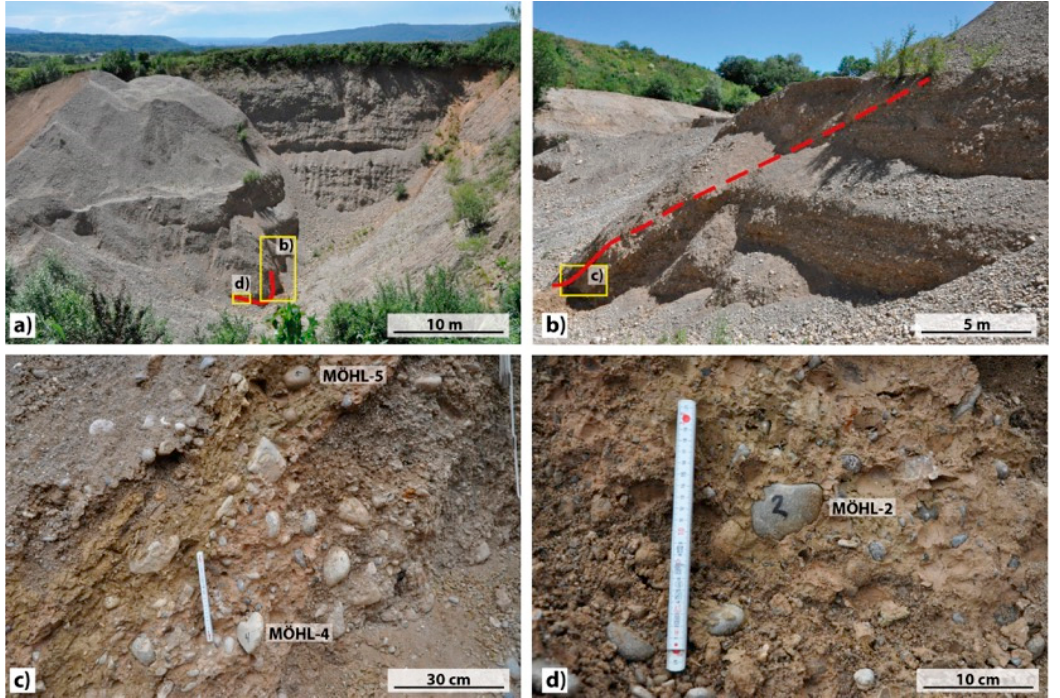
Figure 4. Field photographs of the Möhlin site. ( a ) Overview of the Bünten gravel pit and spatial positioning of Figure 4b,d; ( b ) the Bünten Till (indicated by the red line) and spatial positioning of Figure 4c; ( c ) samples MÖHL-4 and MÖHL-5; and ( d ) sample MÖHL-2.